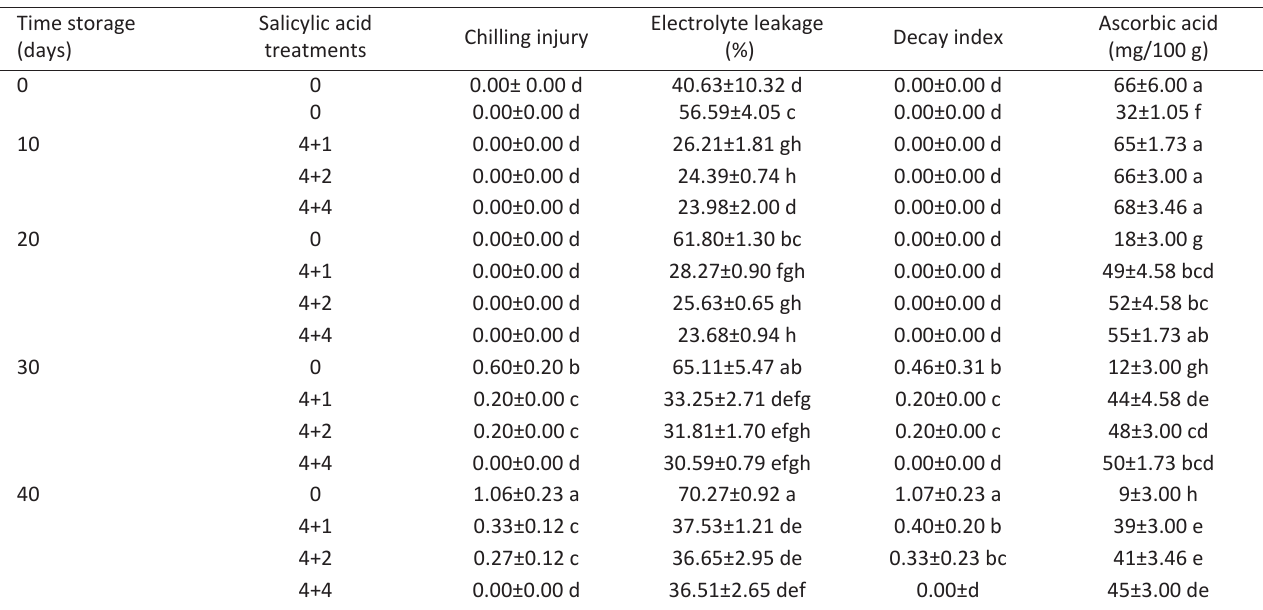
Table 2 - Effect of pre and postharvest treatments of salicylic acid in chilling injury, electrolyte leakage, decay, ascorbic acid of tomato fruit cv. Baraka and stored at 10°C for up to 40 days sampling.Time Means within each column with different superscript letters are significantly different (p = 0.05) for each